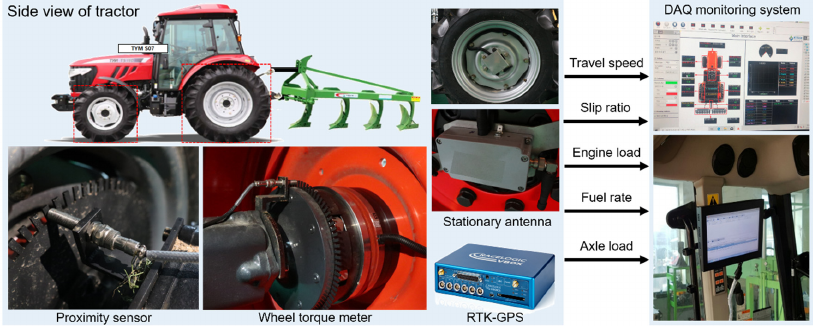
Figure 4. Configuration of load measurement part of the agricultural field measuring system.